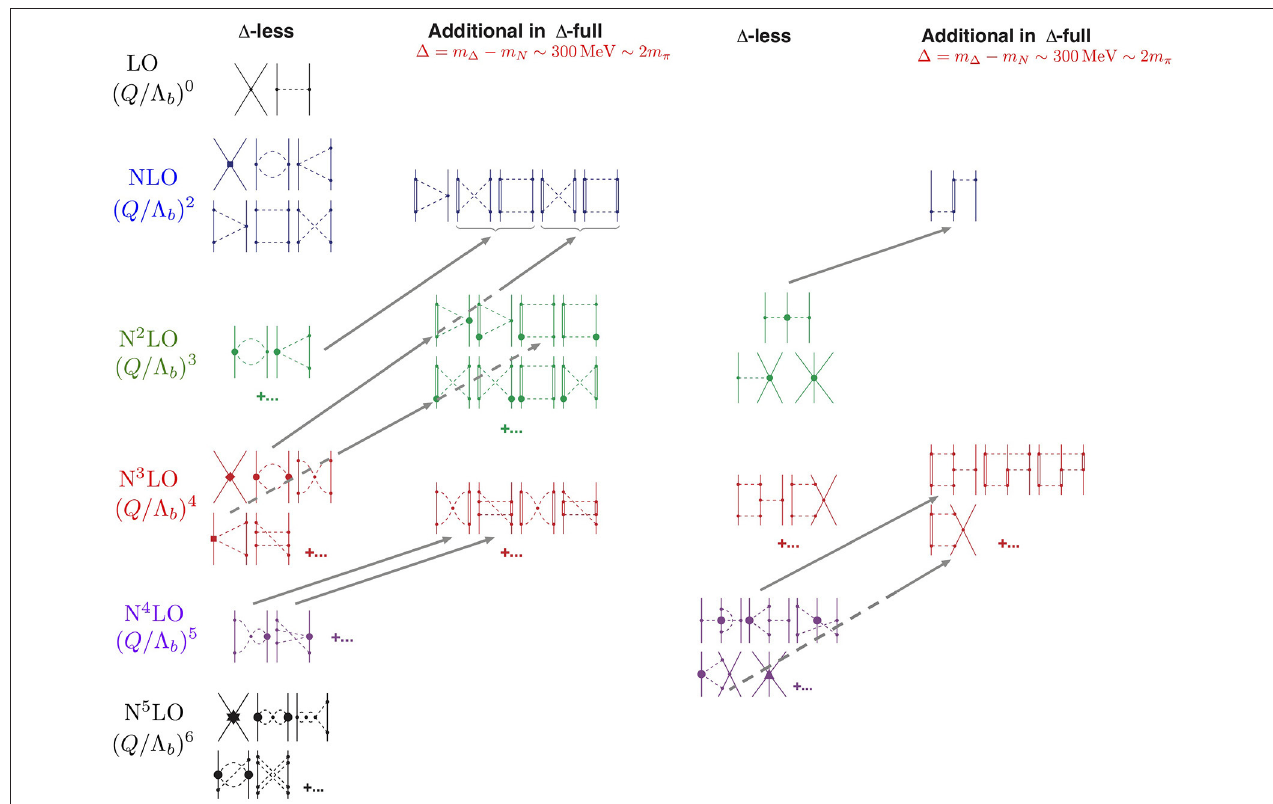
FIGURE 1 | Chiral contributions to the NN and 3 N interactions in the delta-less and delta-full chiral EFT based on Weinberg power counting. Solid lines represent nucleons, dashed lines represent pions, and double lines represent the 1 isobar. Gray arrows indicate the shift of individual contributions within the two power-counting schemes when explicit 1 ’s are accounted for. Figure adapted from Machleidt and Entem [ 41] and Machleidt and Sammarruca [42] under the Creative Commons CCBY license. to Entem et al. [73], Epelbaum et al. [74], Reinert et al. [75], and Entem et al.